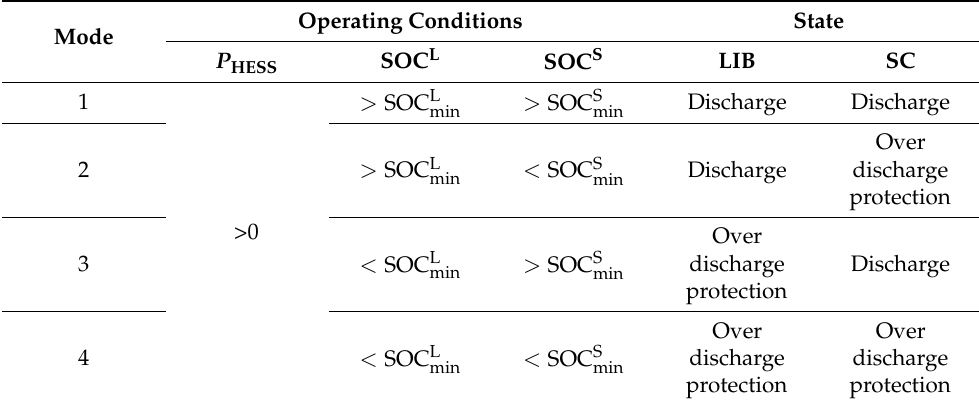
Table 1. The HESS-based auxiliary control strategy.